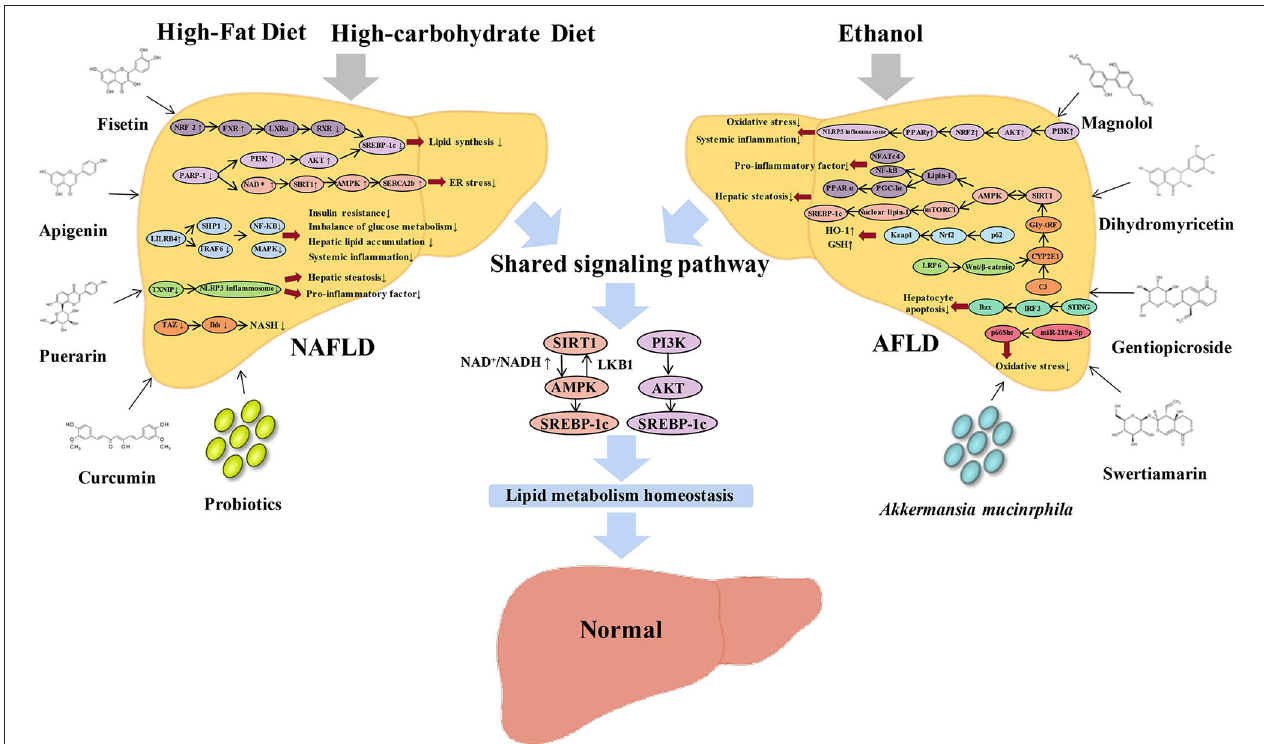
FIGURE 1 | Graphical representation of the comparative review of NAFLD and AFLD signaling pathway and effectors. High fat and high carbohydrate diet-induced NAFLD can be modulated by Nrf2/FXR/LXR α /RXR/SREBP-1c, PI3K/AKT/SREBP-1c, AMPK/SERCA2b, LILRB4/SHP1/TRAF6/NF- κ B/MAPK, and TAZ/Ihh signaling pathways. Ethanol-induced AFLD can be modulated by STING-IRF3-Bax, C3 /CYP2E1/Gly-tRF/SIRT1, LRP6/Wnt/ β -catenin/CYP2E1, and miR-219a-5p/p66Shc signaling pathways. NAFLD and AFLD share two signaling pathways, SIRT1/AMPK/SREBP-1c and PI3K/AKT/SREBP-1c, while other pathways are owned by each other specifically. A variety of natural flavonoids can improve NAFLD, including fisetin, apigenin, puerarin, and curcumin; and AFLD, including magnolol, dihydromyricetin, gentiopicroside, and swertiamarin. In addition, NAFLD and AFLD can also be improved by probiotics and Akkermansia muciniphila . Ultimately, NAFLD and AFLD could be reversed to achieve a homeostasis of lipid